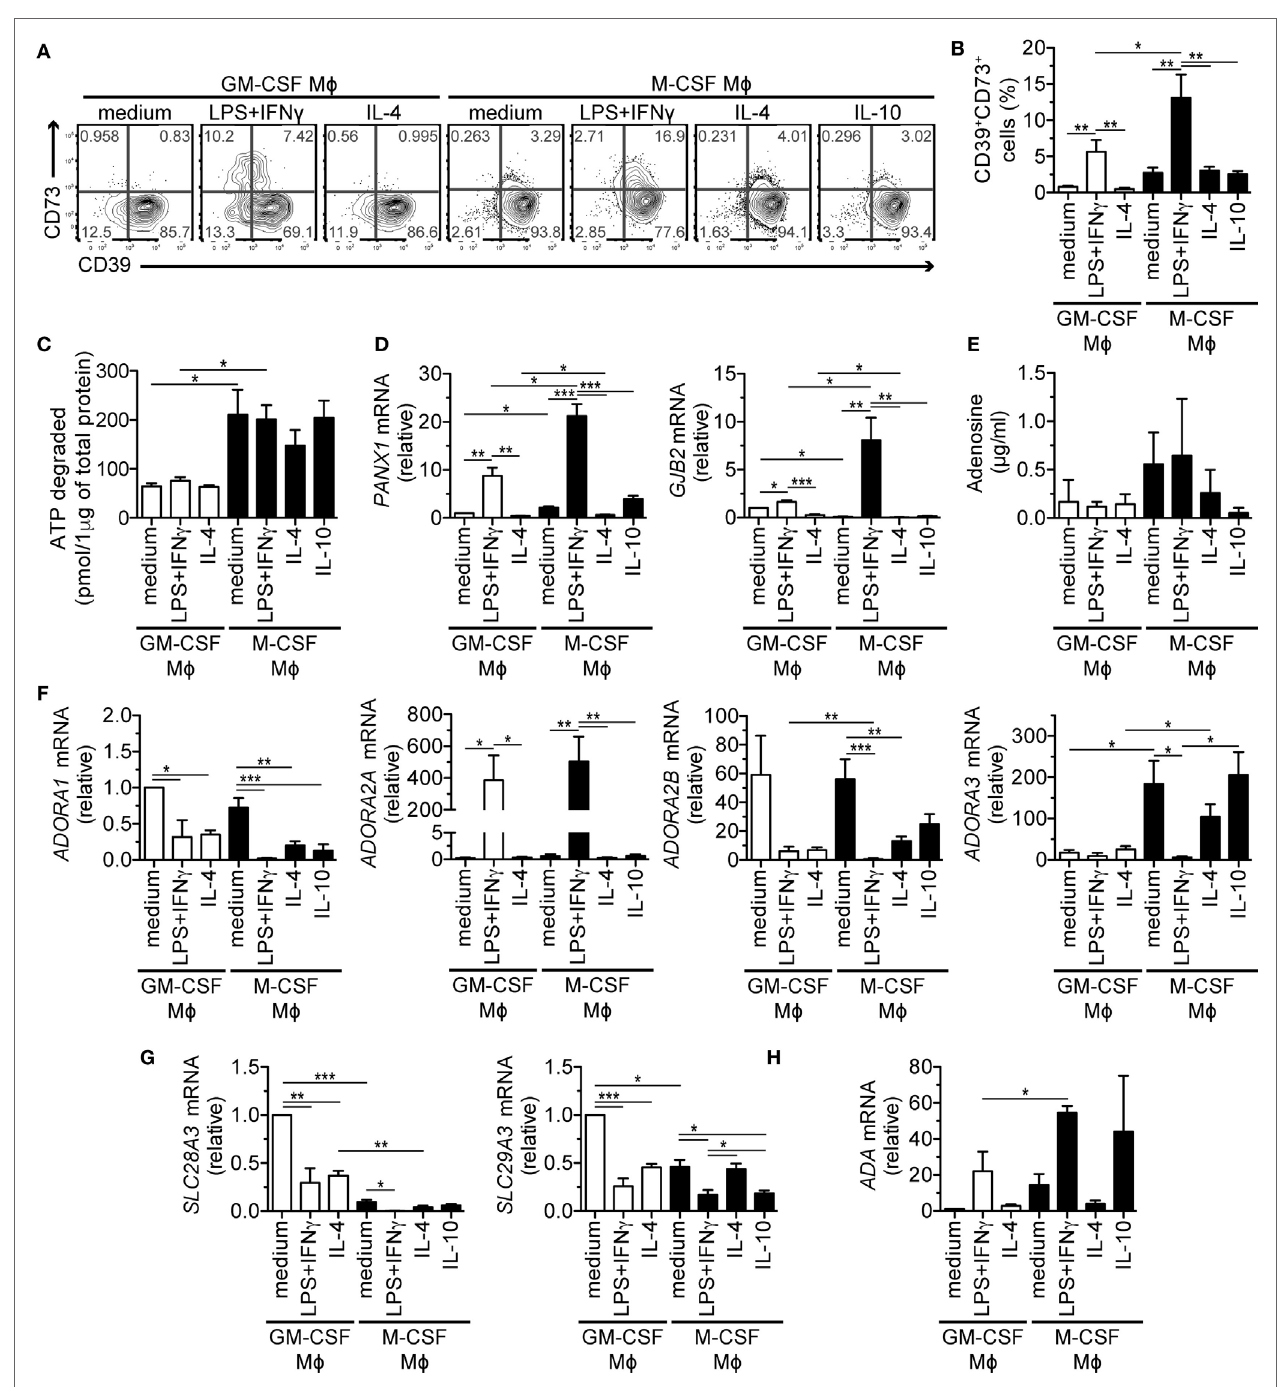
FigUre 3 | Expression and function of genes of the purinergic pathway upon LPS + IFN γ treatment of M-CSF- or GM-CSF-differentiated macrophages (M ϕ s). Human M ϕ subtypes were prepared as described in Figure 1 . (a,B) Surface expression of AMP- and adenosine-producing enzymes CD39 and CD73 on different M ϕ subsets was determined by flow cytometry. One representative experiment (a) and the mean percentages ( ± SEM) of CD39 + CD73 + cells from five experiments are shown (B) . (c) Degradation of 20 µM ATP by M ϕ subtypes. After 30 min, remaining ATP was measured and normalized to the M ϕ protein content. (D) mRNA expression of genes encoding ATP-releasing channels pannexin 1 ( PANX1 ) and connexin 26 ( GJB2 ) was analyzed by qRT-PCR. (e) Adenosine was measured in the cell-free culture supernatants by mass spectrometry. (F–h) mRNA expression of genes encoding (F) adenosine receptors ( ADORA1-3 ), (g) adenosine uptake channels ( SLC28A3 , SLC29A3 ) and (h) the adenosine-catabolizing enzyme adenosine deaminase ( ADA ) was analyzed by qRT-PCR. To compare the expression of the various adenosine receptors, we normalized the data to ADORA1 mRNA levels in GM-CSF control M ϕ s that were set to one. Other genes were normalized to the respective levels found in GM-CSF control M ϕ s that were set to one (D,g,h) . Data in (c–h) represent mean values ± SEM of three (c,D,g,h) to five (e,F) donors. Statistical significance was assessed by one-way ANOVA with Tukey’s posttest; * p < 0.05, ** p < 0.01, *** p < 0.001.